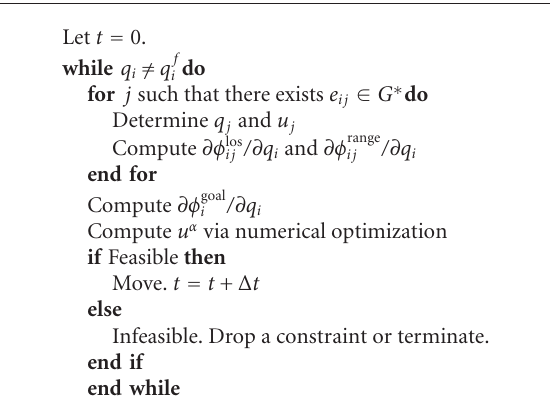
Figure 8: A swarm of 5 robots maintaining a specified communi- cation graph, beginning in the lower left corner and moving toward the upper right corner.